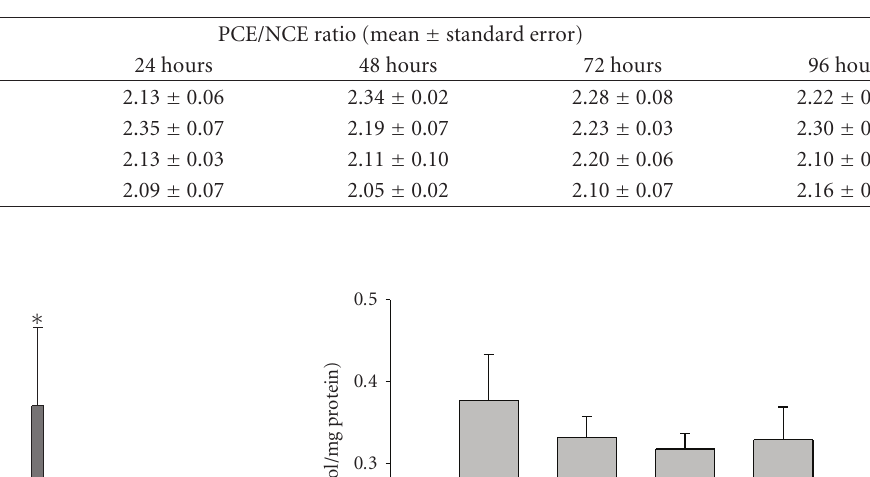
Table 1: The ratio of polychromatic erythrocytes/normochromatic erythrocytes (PCE/NCE) in rat peripheral blood after 0, 24, 48, 72, and 96 hours in the four treatment groups